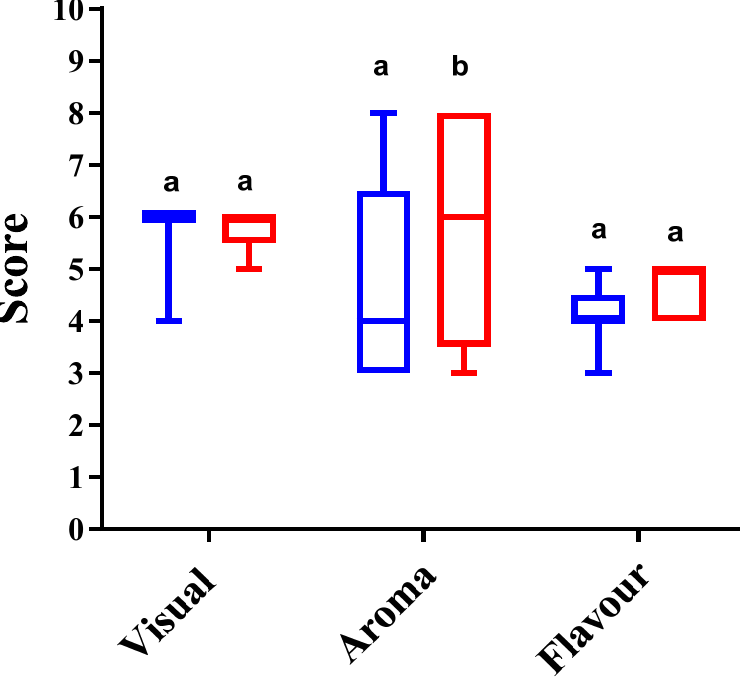
Figure 3. Sensory evaluations of the sparkling wines obtained with the two yeast starter cultures for the second fermentation, displayed as means and LSD intervals at 95%. Blue depicts the GPY-grown yeasts and red the pied de cuve -prepared yeasts. Different letters indicate significant differences between wines. The sensorial panel was made up of 16 persons.